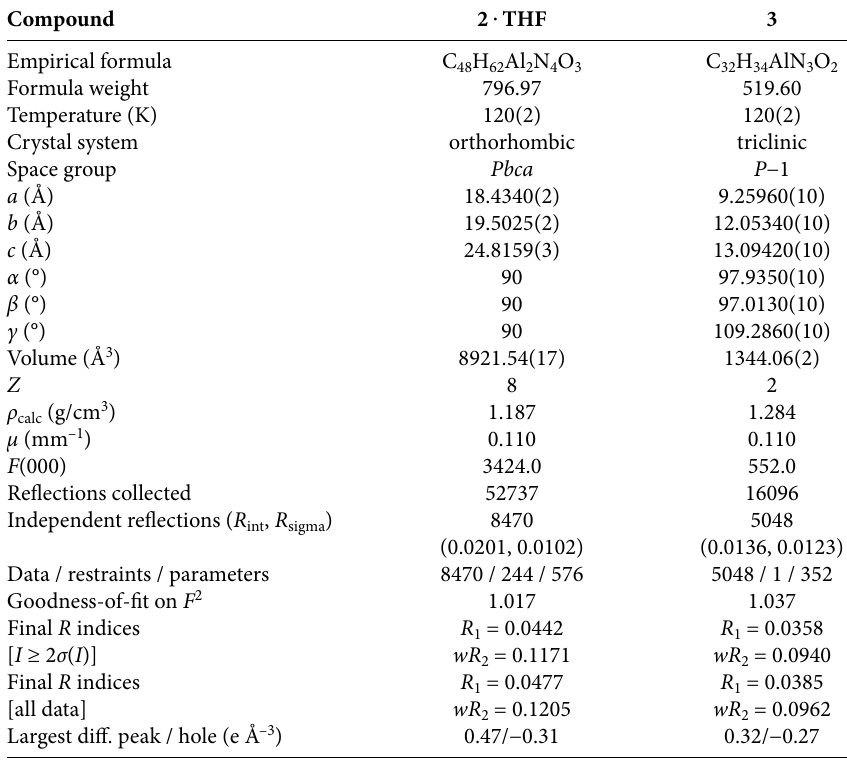
Table 1. Crystal data and structure refinement